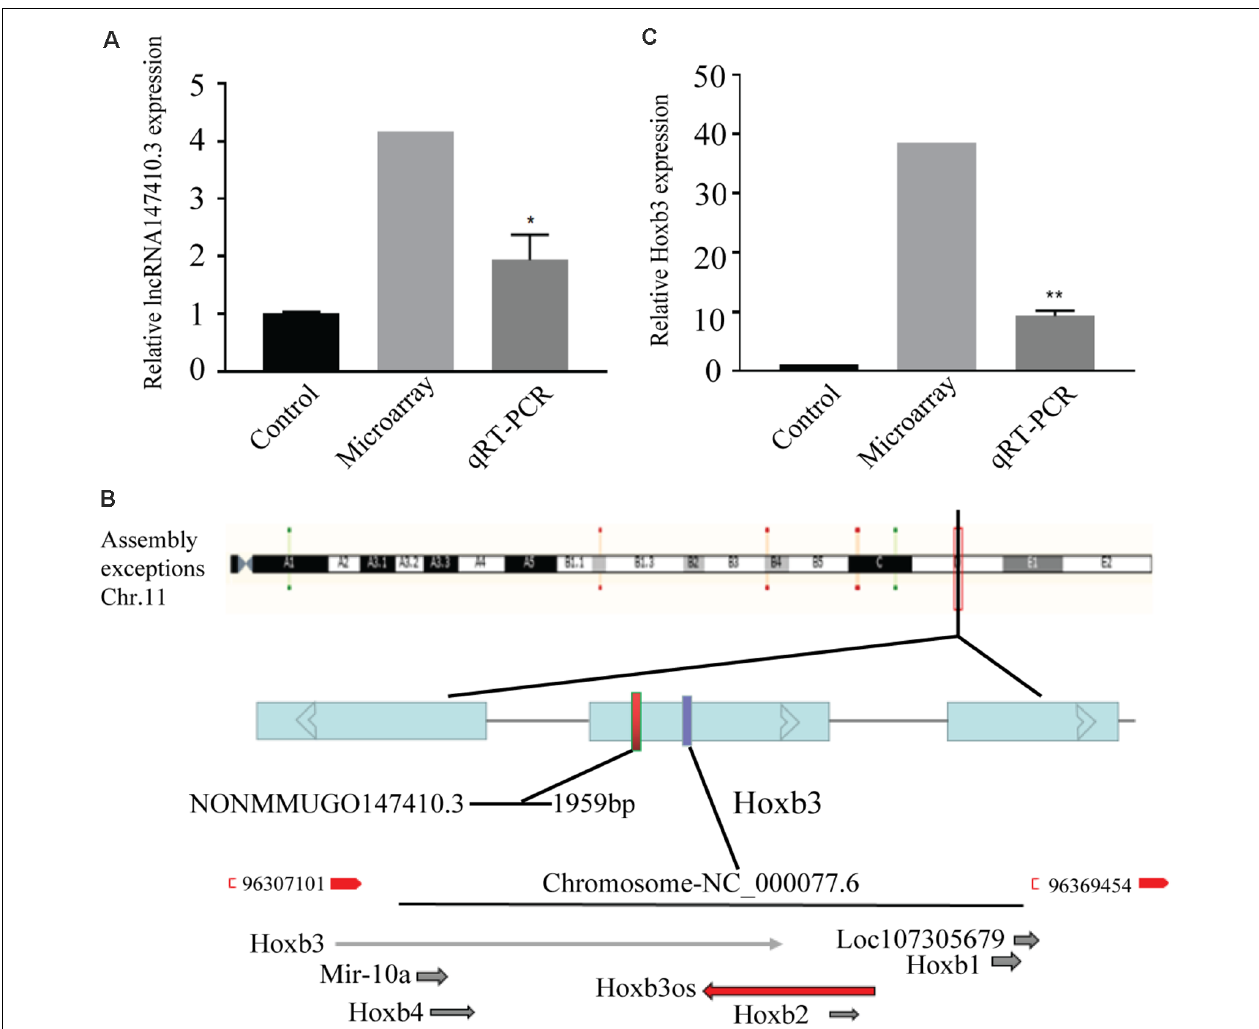
FIGURE 1 | The expression of lncRNA147410.3 in the Toxoplasma gondii ( T. gondii ) infected mice brain and the prediction of its target gene. (A) The expression of lncRNA147410.3 was tested in the mice brain infected with T. gondii by microarray and quantitative polymerase chain reaction (qPCR). (B) Prediction the location of the target gene of lncRNA147410.3. (C) The expression of Hoxb3 in the infected mice brain. All values are presented as mean ± SD for three independent experiments. * p < 0.05, ** p < 0.01, Student’s t -test.